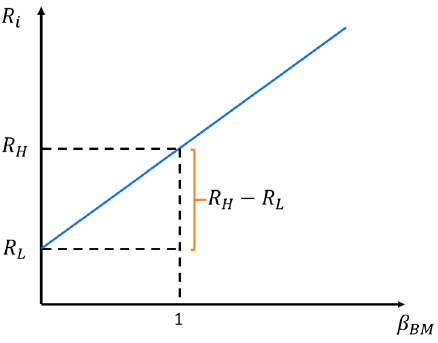
Figure A4. Relationship between true and cognitive value of stocks with the growth of MV/B. For the higher B/M ratio companies, the MV/B is relative lower and people always overprice the true value of a stock, it leads to the demand for those companies is higher. With the growth of demand and stock price, the return of those stocks also is higher. Vice versa, higher B/M ratio companies has lower expected return and excess return (expected return minus risk of free rate). Therefore, if the investor prefers higher B/M ratio companies, they take the risk of B/M effect on one hand, they gain the B/M premium on the other hand. 4.